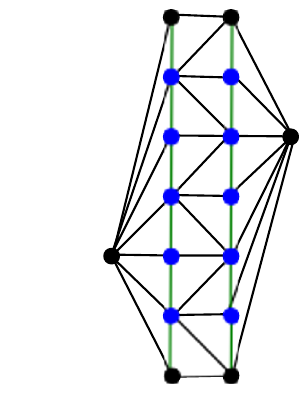
(cid:2) SU( N ) N linear quiver. On the + k 1 + k 2 2 2